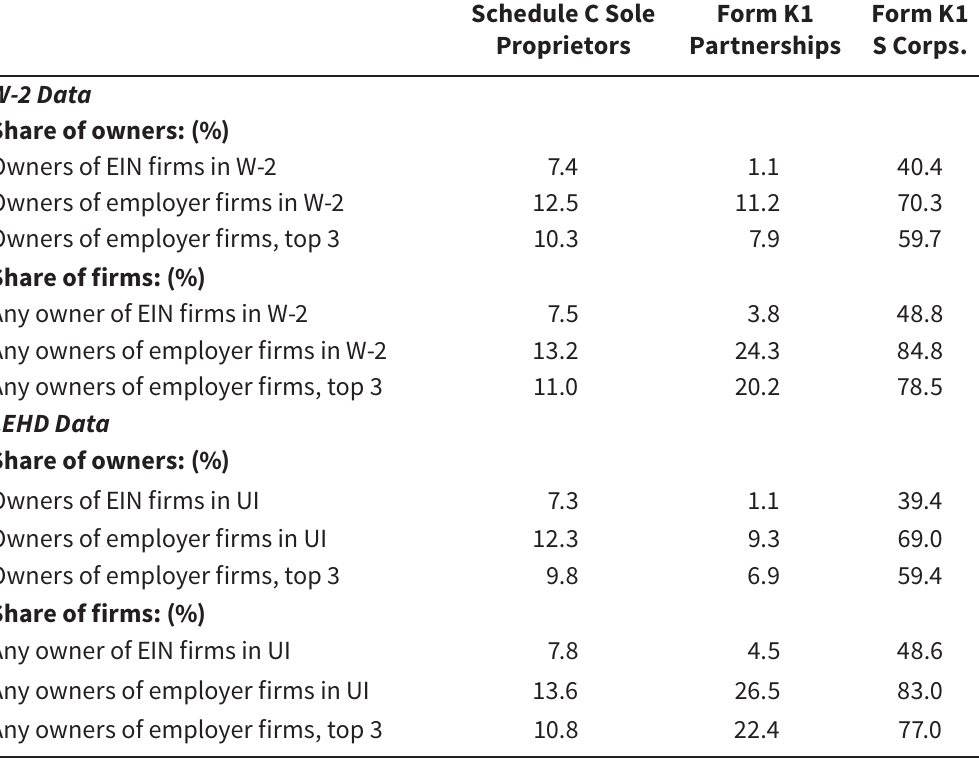
Share of business owners who receive wage and salary payments